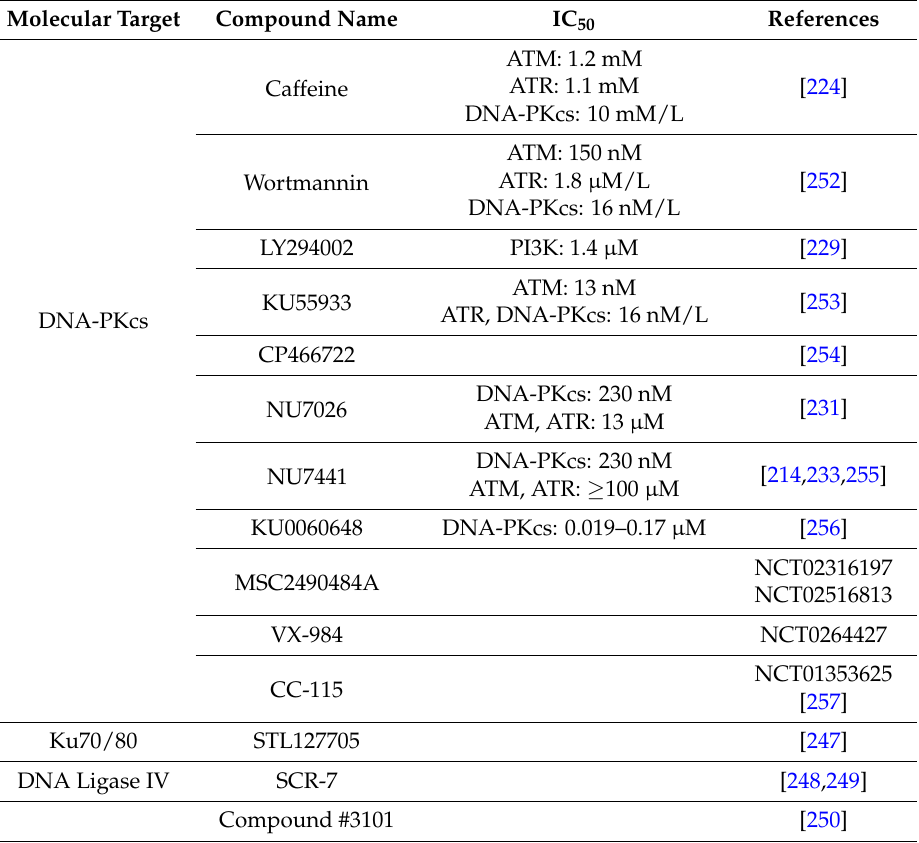
Table 1. List of compounds targeting the core NHEJ